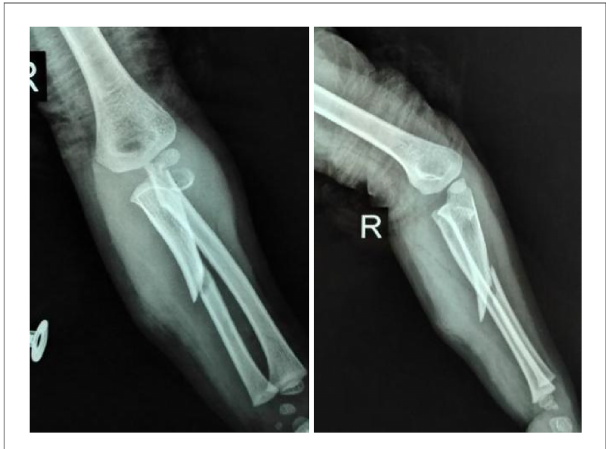
FIGURE 1 Extension-valgus type, an ulnar fracture with volar ulnar angulation plus a radial neck fracture with a volar ulnar displacement of the distal